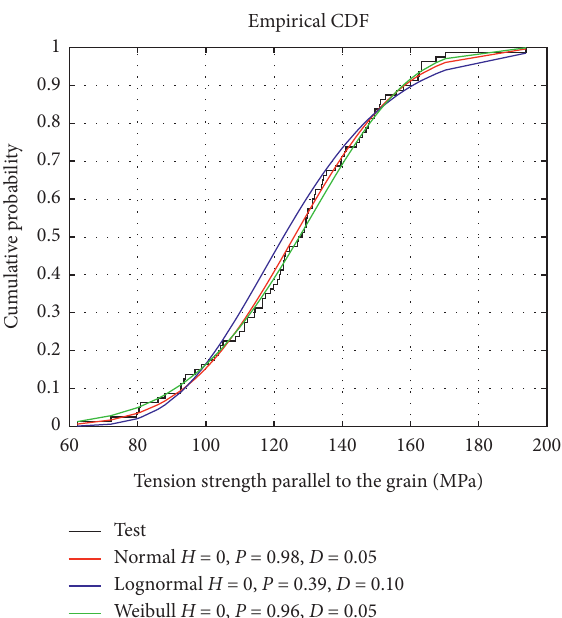
Figure 5: Example of the Kolmogorov–Smirnov tests for the goodness of fit